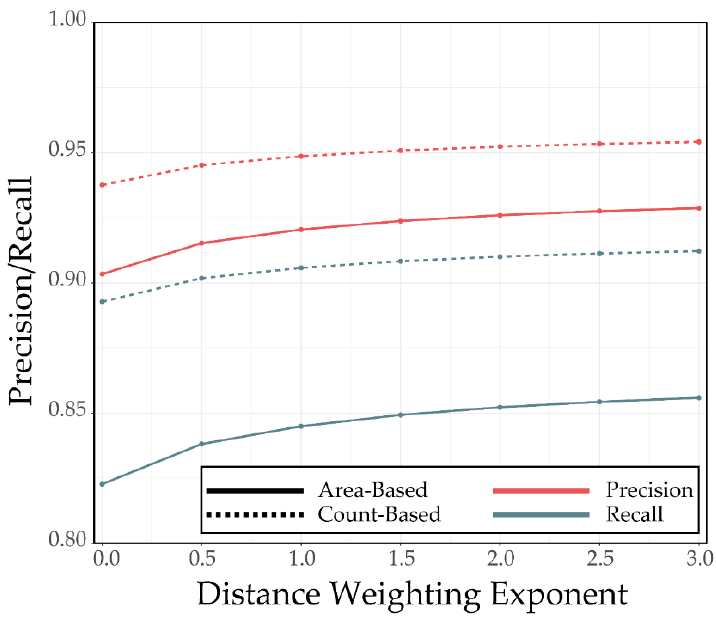
Figure 8. Impact of distance weighting exponent on resulting precision and recall estimates. Solid lines pertain to metrics derived from the area-based method while a dash pattern represents those obtained from the count-based method. The point and line color differentiate the assessment metric (precision or recall).